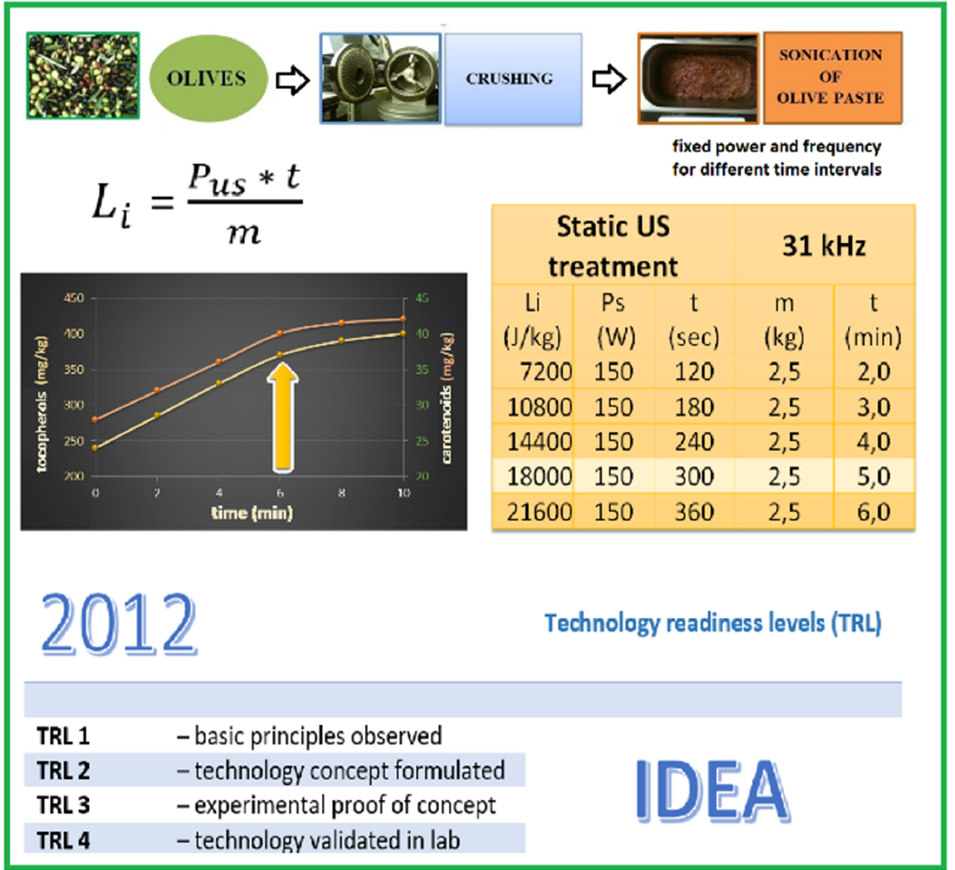
Figure 2. From the basic principles observed to the technology validated in a laboratory.